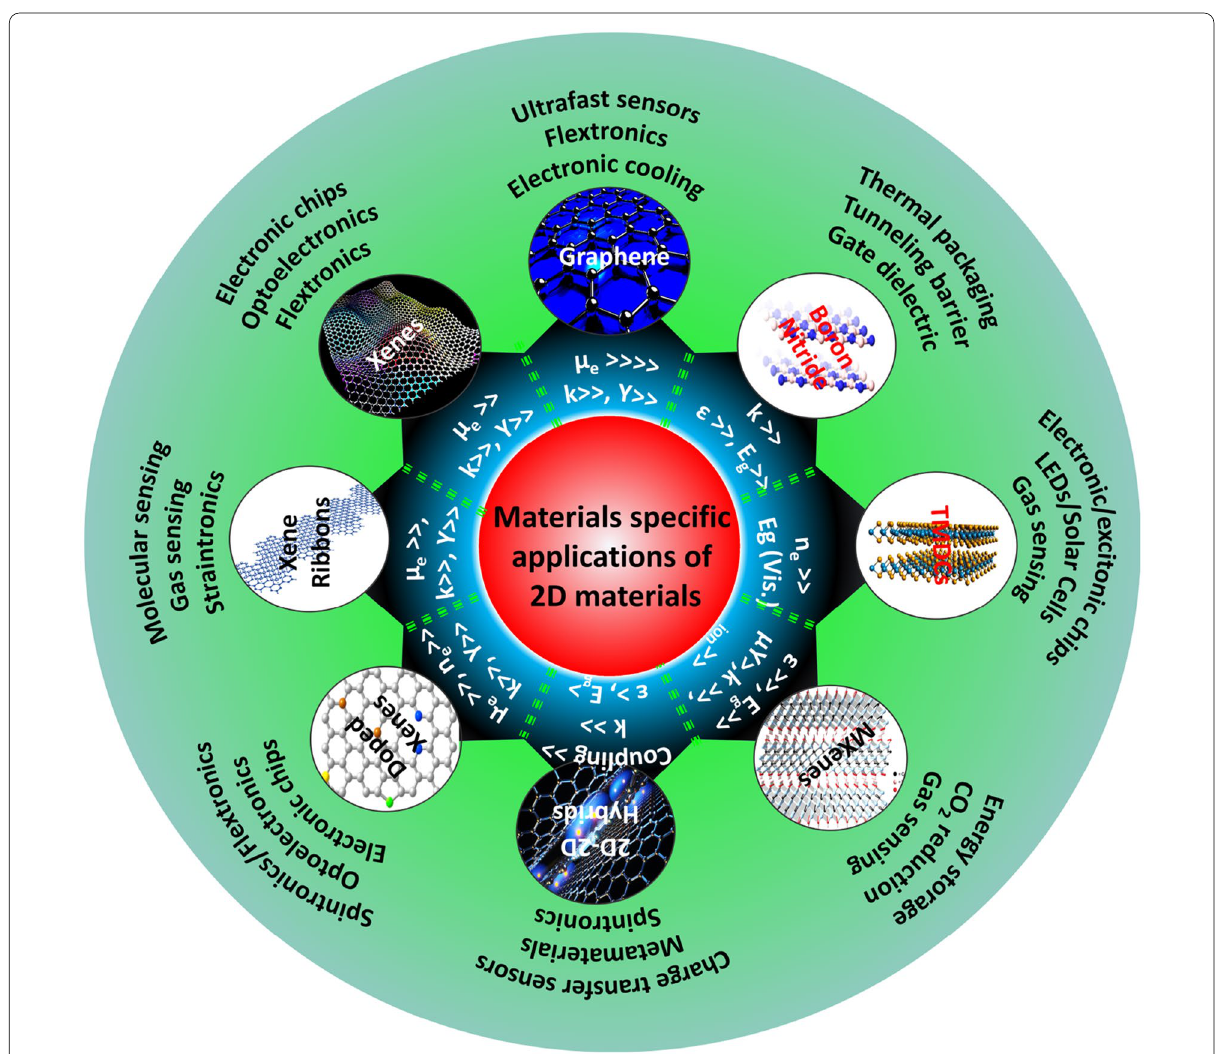
Fig. 13 Materials specific applications of various classes of 2D